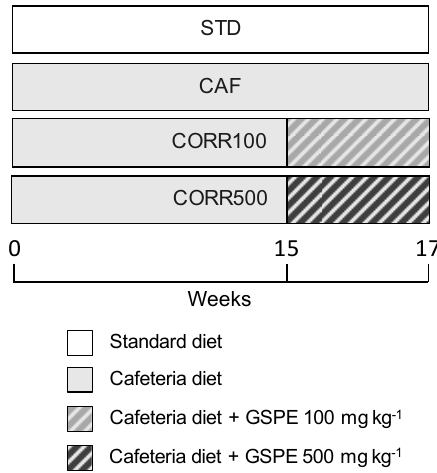
Figure 1. The schematic diagram of the experimental design. STD group, rats fed standard chow diet; CAF group, rats fed cafeteria (CAF) diet; CORR100 group, CAF-fed rats supplemented with 100